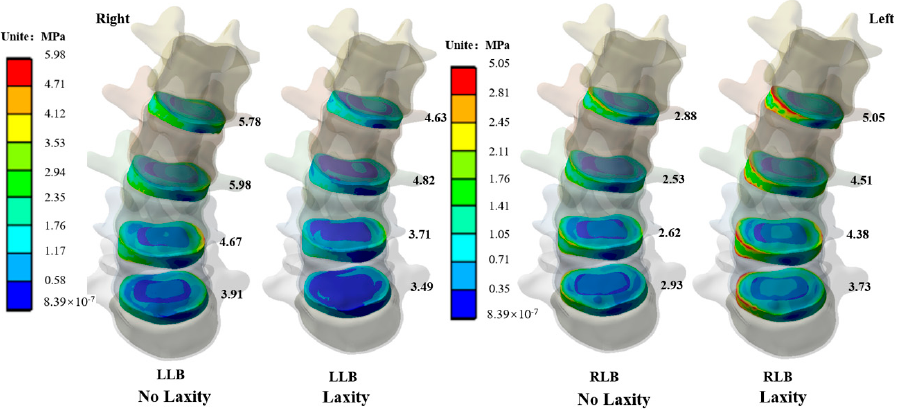
Figure 5. Stress distribution of IVD under lateral bending load.